Question: Write a single sentence explaining what this figure depicts.
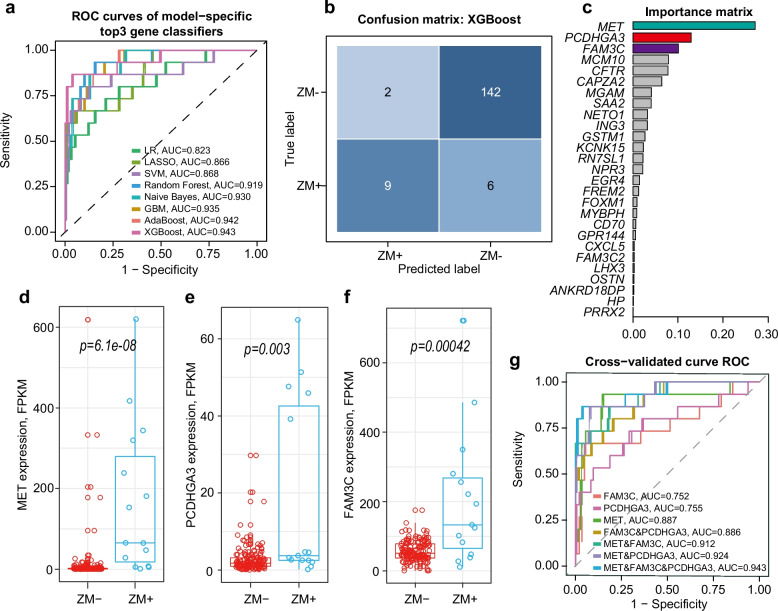
Answer: Machine-learning analysis identifies a three-gene transcriptomic signature associated with ZM fusion status. a Cross-validated ROC curves of eight model-specific three-gene classifiers generated from the Top40 candidate gene set. The AUC values of each classifier are shown in the plot. b Confusion matrix of the representative XGBoost model at the prespecified probability threshold of 0.5. c Gain-based feature-importance ranking from the XGBoost model, identifying MET, PCDHGA3, and FAM3C as the top-ranked candidate biomarkers. d–f Expression levels of MET, PCDHGA3, and FAM3C in ZM-positive and ZM-negative tumors. Each dot represents an individual patient sample, and statistical significance was assessed using the Mann–Whitney U test. g Cross-validated ROC curves evaluating single-gene, pairwise, and combined three-gene XGBoost classifiers. The combined MET/FAM3C/PCDHGA3 panel showed the highest discriminative performance among the tested combinations